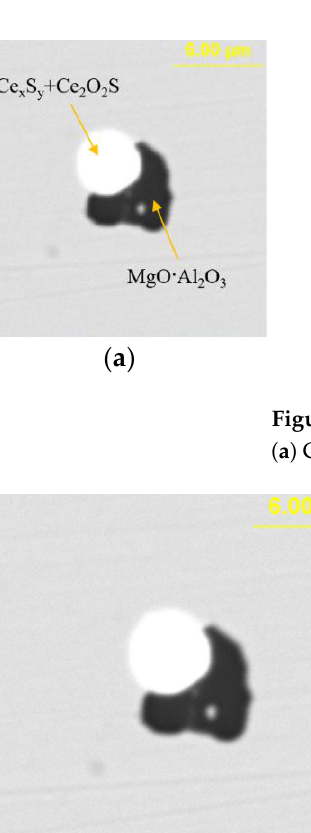
Figure 13. Elemental mapping of a typical inclusion in the steel with 95 ppm Ce content.